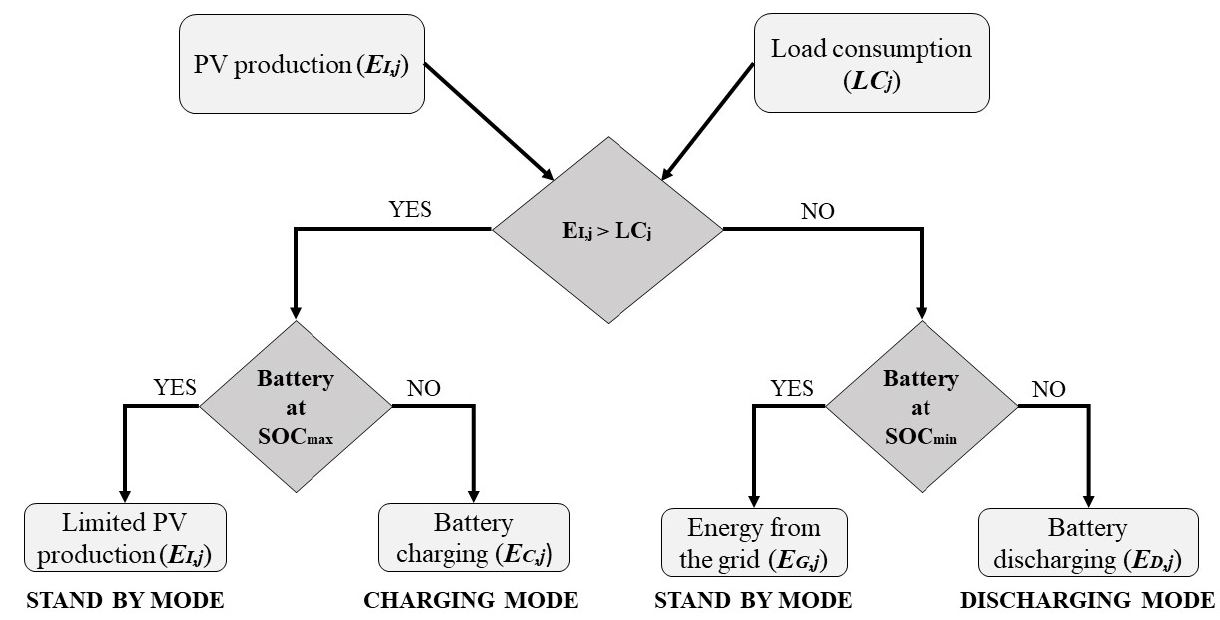
Figure 4. Prototype operation.